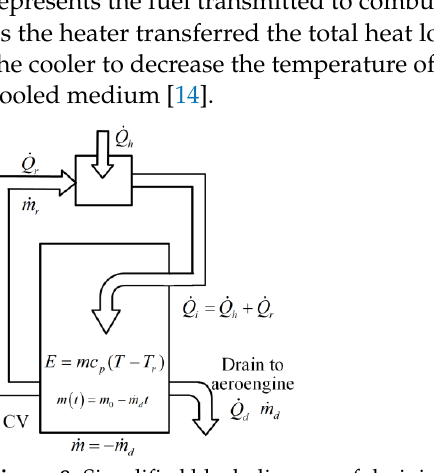
Figure 8. Simplified block diagram of draining tank with a heat exchanger in recirculation.